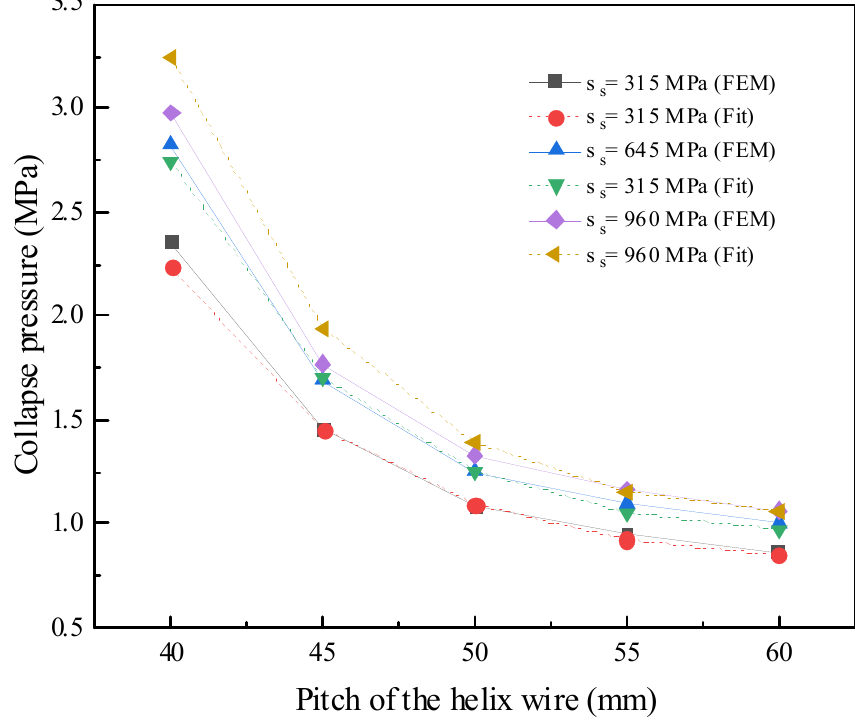
Figure 21. Comparison of FEM and equation results with respect to different distances of helix wire.